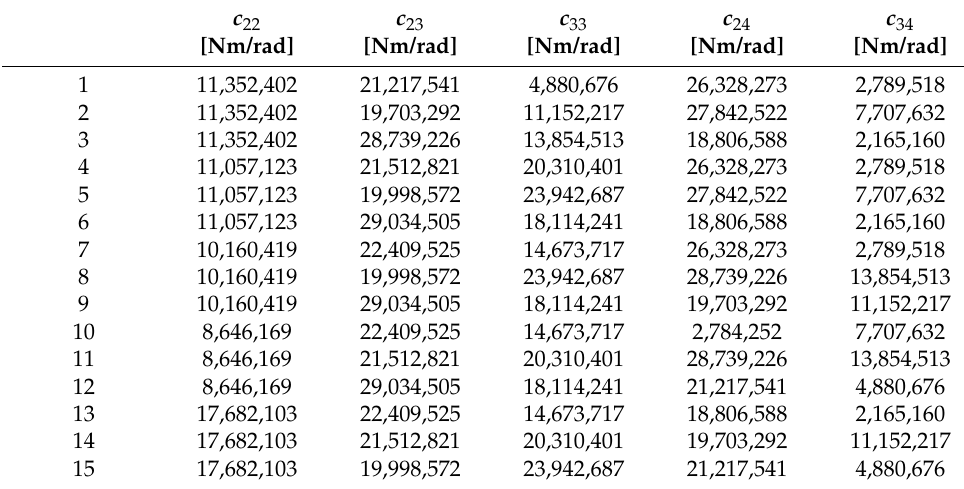
Table 2. Parameters of elastic components.